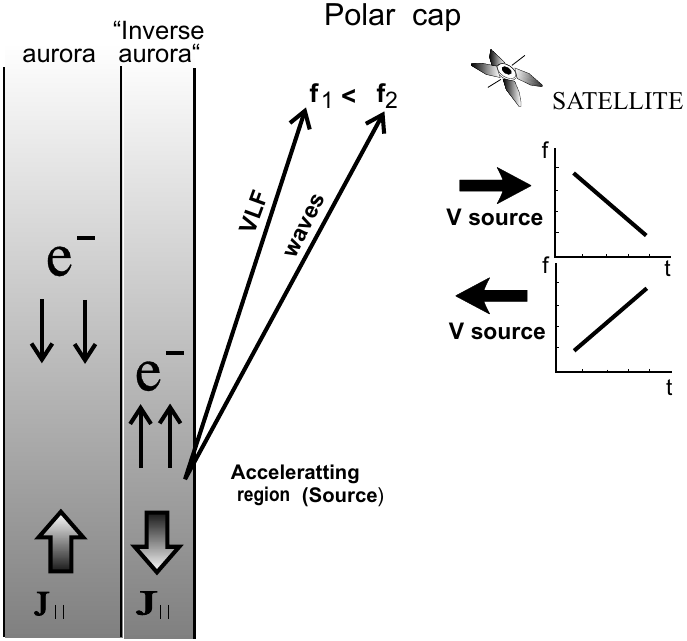
Fig. 10. A schematic showing the relationship between the characteristics of auroral hiss and the auroral dynamics. The left part shows the Birkeland current system, where downgoing and upgoing beams of accelerated electrons are formed. The upgoing beams generate the upgoing VLF waves. Resonance VLF waves having higher frequencies propagate at larger angles to the magnetic field. The right part shows the auroral hiss frequency alteration depending on the direction of movement of the electron upward acceleration region. The auroral hiss frequency registered by the satellite in the polar cap decreases as the upward electron acceleration region (a source of auroral hiss) approaches the satellite and vice